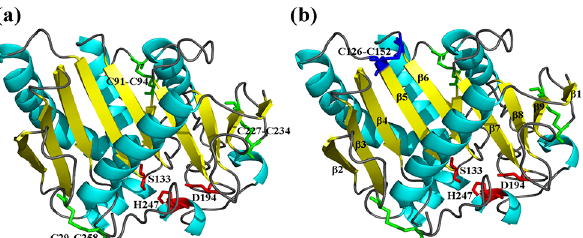
The catalytic triad S133-H247-D194 and three native disulfide bridges C29-C258, C91-C94, C227-C234 are separately marked in red and green. (b) The extra disulfide bridge C126-C152 located in AuFaeA A126C-N152C is marked in blue.